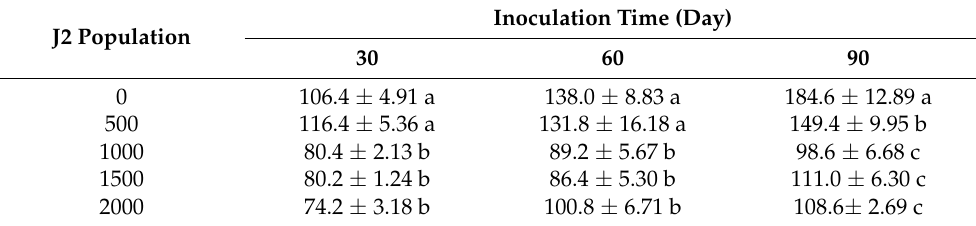
Table 1. Plant height growth rate of rice in the first experiment (%).